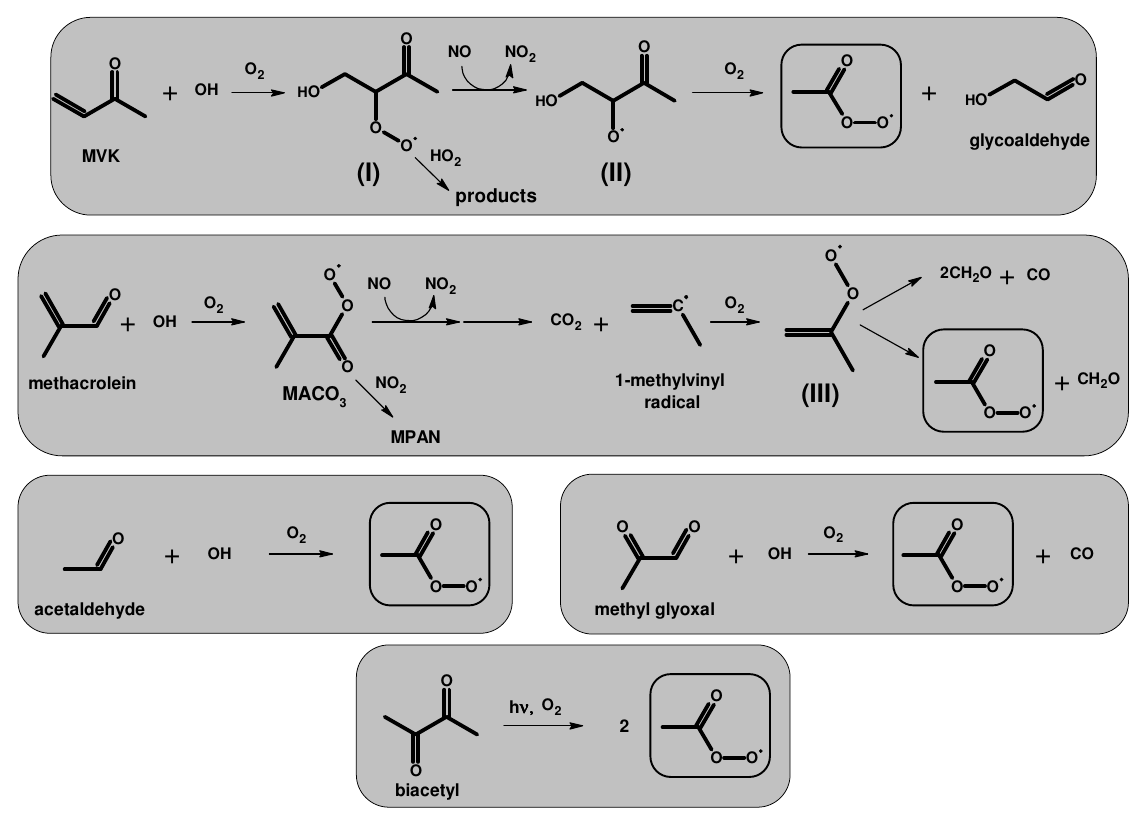
Scheme 2. Reaction mechanisms for the production of the peroxy acetyl radical (PA), which is outlined by a box in each case. The pathways to PA radical from these five compounds are shown in Scheme